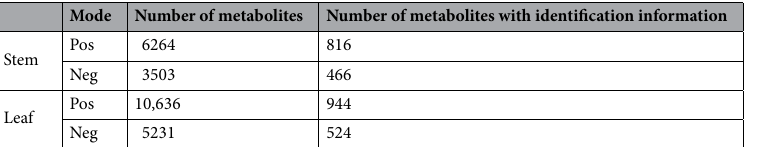
Table 2. Statistical table of compound detection.